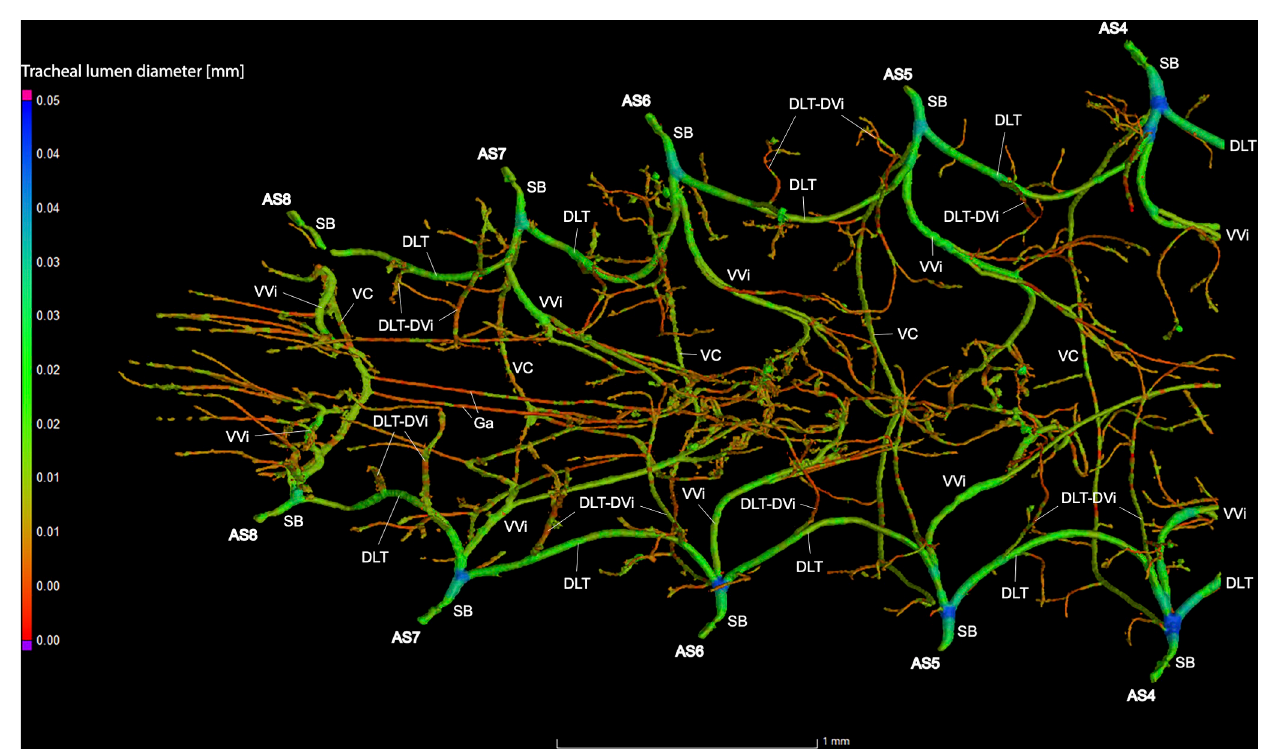
Fig 5. Dorsal view of the abdominal tracheal system in Photinus pyralis 3–4 day-old pupa.